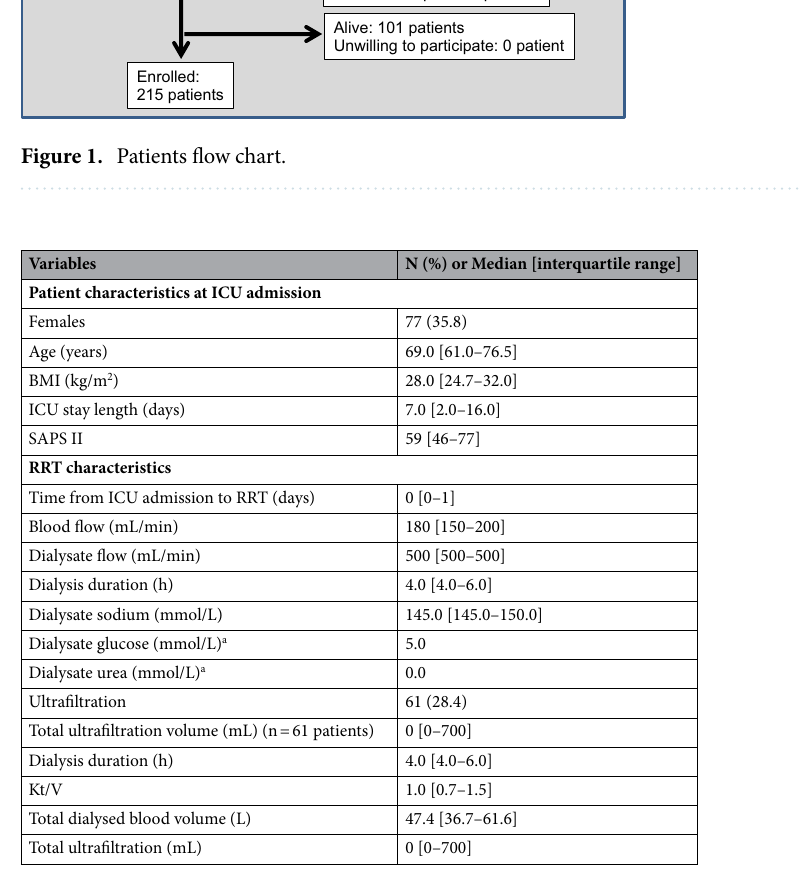
Table 1. Main characteristics of the 215 study patients and first renal replacement therapy (RRT) session. RRT renal replacement therapy, BMI body mass index, ICU intensive care unit, SAPS II Simplified Acute Physiological Score II. a The concentrations of glucose and urea in the dialysate were identical in all patients.